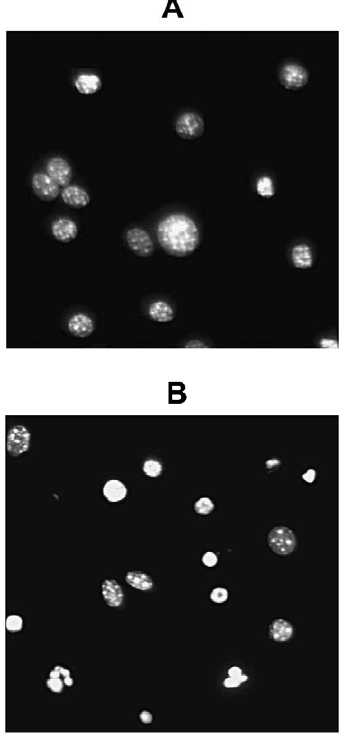
Fig. 2. Colony formation in soft-agar medium by NIH 3T3 Neo r (A), and clones constitutively expressing HCV core NIH191-3 (B), and NIH191-10 (C).